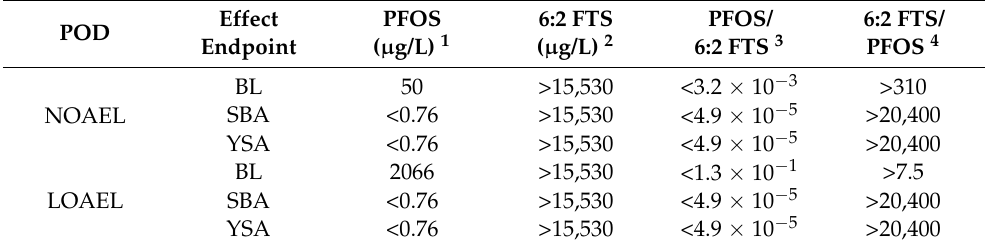
Table 3. NOAELs, LOAELs, and POD ratios for PFOS and 6:2 FTS.